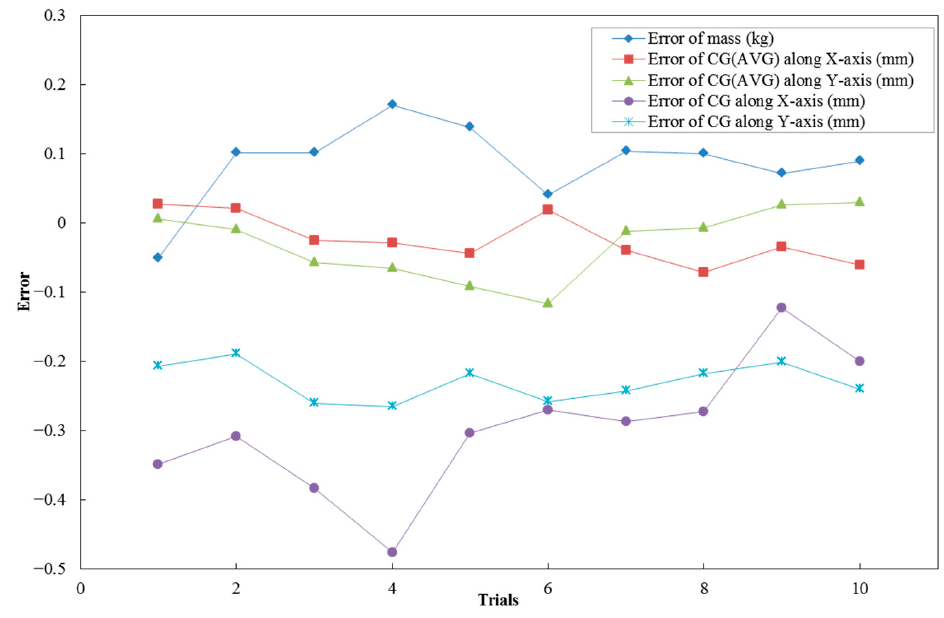
Figure 7. Standard sample mass centroid measurement error.